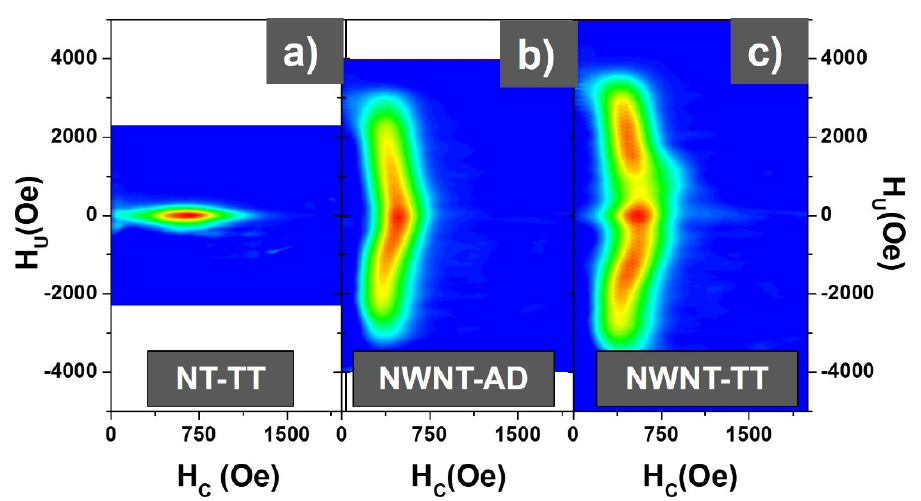
Figure 5. FORC distributions for ( a ) NT-TT sample with only magnetite nanotubes; ( b ) NWNT-AD sample with only FeCo ferromagnetic nanowires; and ( c ) NWNT-TT bimagnetic core/shell sample. Previous analyses point out that the difference between the nanowire and core/shell systems is the delay of the switching process of the nanowires, represented by a shift towards higher values of the external magnetic field. The presence of the magnetic nanotubes in the core/shell nanowire system, increased the magnetostatic interaction felt by the nanowires, so that the antiparallel coupling between the core and shell is favored. However, magnetostatic interaction among neighboring nanowires is still dominant, as inferred from hysteresis loops and also from FORC analyses. In order to better clarify the magnetization reversal process of individual core/shell nanowires, magneto-optical Kerr effect measurements have been performed with the applied magnetic field parallel to the core/shell longitudinal axis. In Figure 6, the VSM and MOKE parallel hysteresis loops are compared for several samples. The NT-TT VSM and NWNT-AD VSM parallel loops are included as a reference for the magnetization reversal of the nanotubes and the nanowires, respectively. As it can be appreciated from the comparison between the respective VSM and MOKE measurements, the switching field of the single nanowire (NWNT-AD sample with no magnetic shell measured by MOKE, in purple color) matches well with the coercive field value of the FeCo nanowires array measured by VSM (dark yellow color). Furthermore, the blue-colored loop in Figure 6, corresponding with the MOKE hysteresis loop of a single core/shell bimagnetic nanostructure, presents two well-differentiated magnetization jumps. The first one seems to correspond to the ferromagnetic FeCo nanowire in the core, as compared with the one observed for the NWNT-AD sample (purple and dark yellow colors), whilst the second reversal of magnetization is ascribed to the shell of magnetite nanotube, as it is located near the coercive field value of the NT-TT sample obtained from the corresponding VSM hysteresis loop (red color).